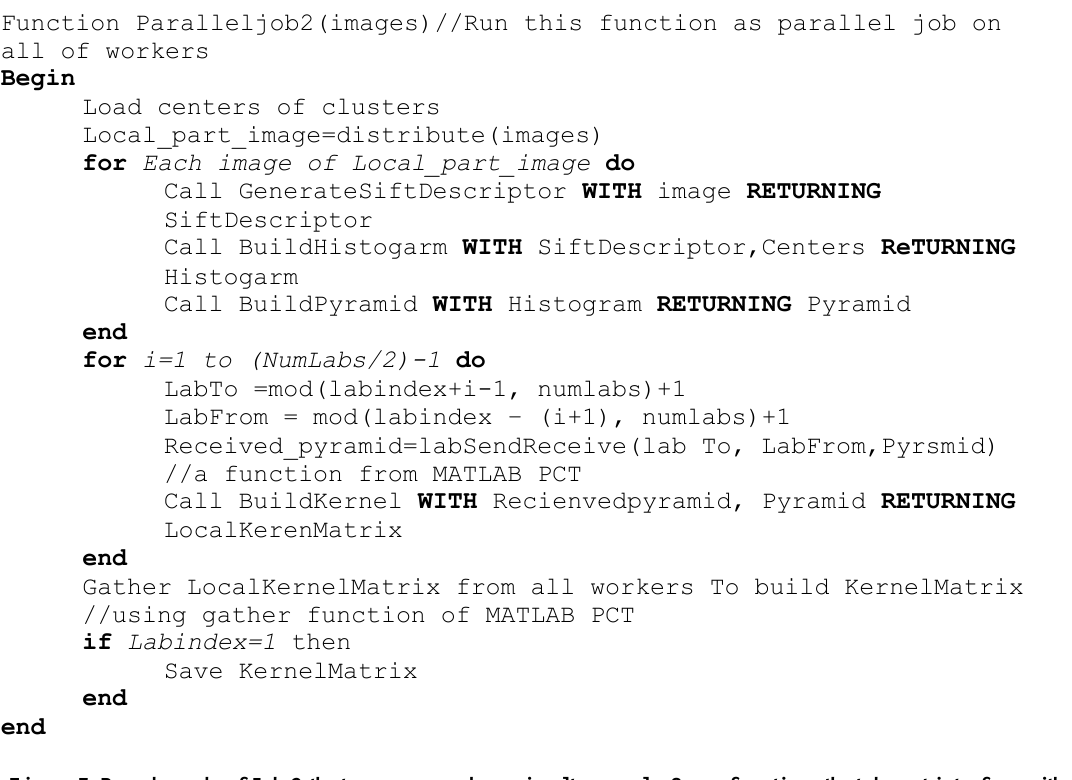
Figure 7. Pseudo-code of Job 2 that runs on workers simultaneously. Some functions that do not interfere with parallel implementation are considered as black box and are just